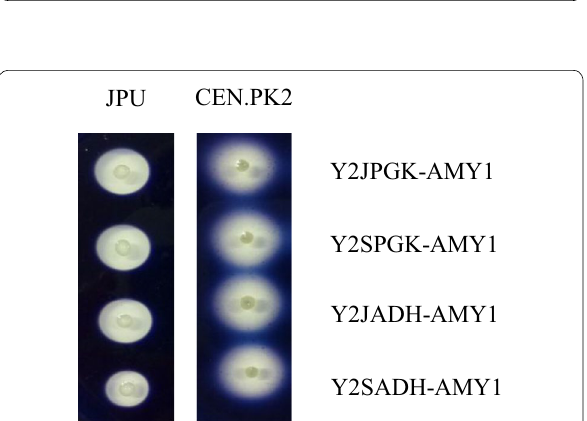
Fig. 3 Amylolytic activity of yeast transformants in plate assays. S. cerevisiae JPU and CEN.PK2 were transformed with the indicated plas- mids and plated in MD medium supplemented with 1% starch. After 24 h (JPU) and 48 h (CEN.PK2) of growth at 30 °C, the plates were stained with iodine vapor. The different growth time between strains was due to the slower growth rate of CEN.PK2 laboratory